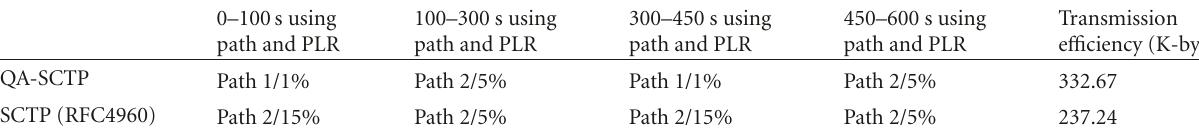
Table 4: QA-SCTP path condition measure/switch experiment data.